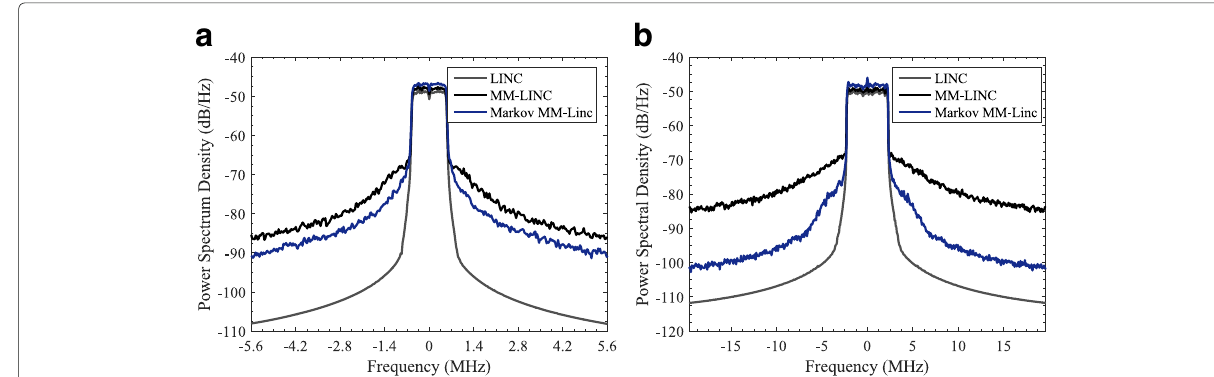
Fig. 6 Simulation results with LINC, MM-LINC, Markov-LINC, and direct amplification. a OFDM with 1.4 MHz bandwidth. b OFDM with 5 MHz